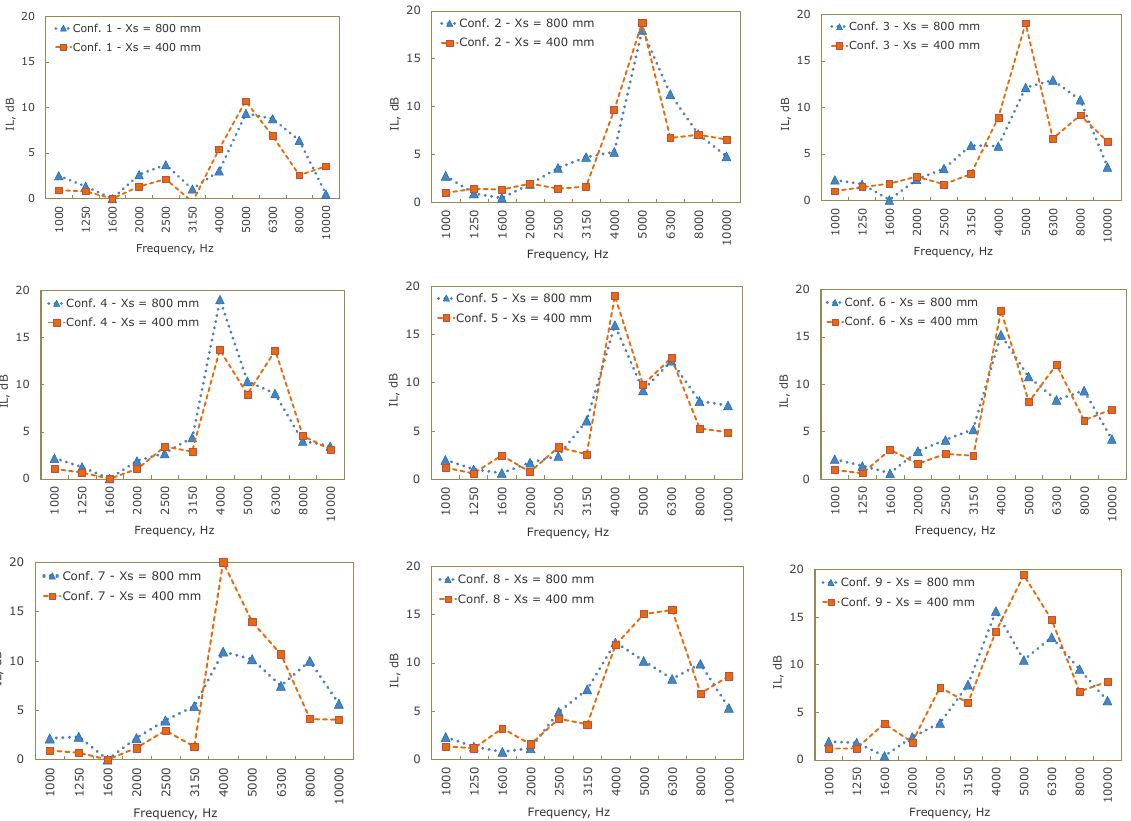
Figure 7. Insertional Loss (IL) comparison between 1st and 2nd set of measurements, related to all the configurations of scatterer layout. Distance between source and edge of barrier ( Xs ) is equal to 800 mm for the dotted-blue lines and to 400 mm for the dashed-orange lines. Distance between receiver and edge of barrier ( Xr ) is equal to 800 mm.